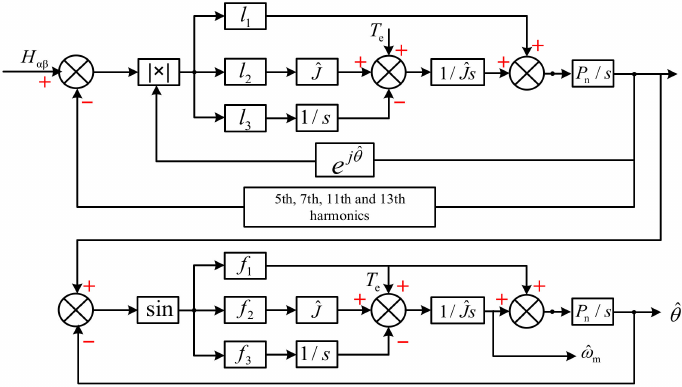
Figure 10. Block diagram of the proposed dual observer.